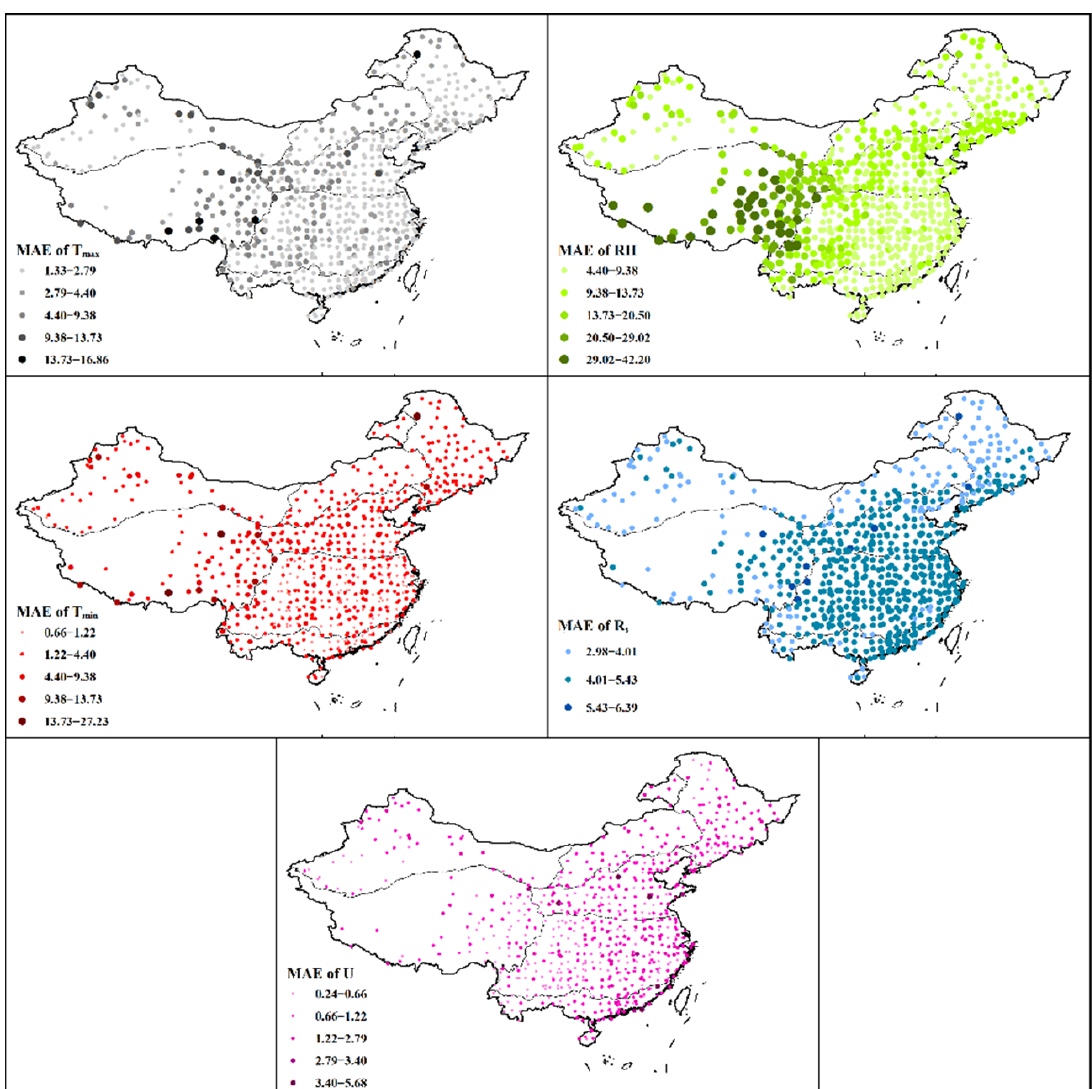
Figure 2. RMSE values of the five meteorological factors of in all stations.